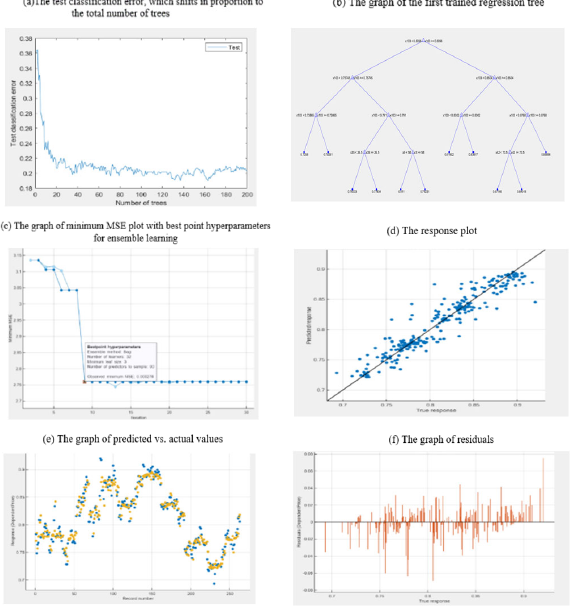
Fig. 6. Performance Graphs of Prediction Made with Ensemble Learning Method